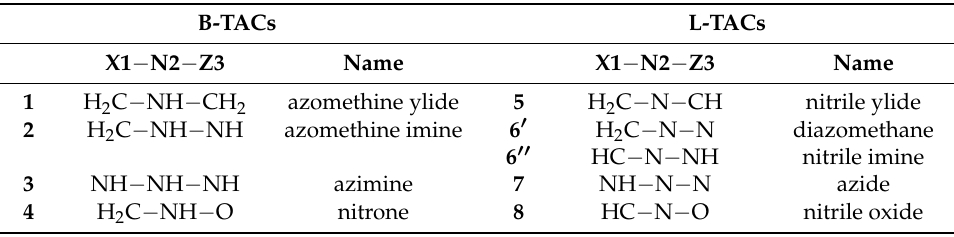
Table 1. Atom composition and name of the pairs of B- and L-TACs studied